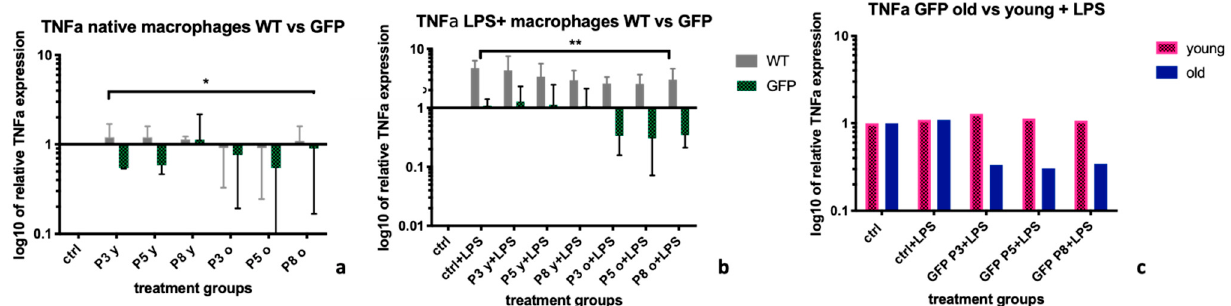
Figure 3. TNF α expression levels in BMDMs after treatment with MSC-wildtype versus MSC-GFP+ supernatants of different age groups and passages. The graph shows the influence of different supernatants from Mesenchymal Stromal Cells on the expression levels of Tumor necrosis factor α (TNF α ) on BMDMs extracted from a WKY-WT rat . Supernatants from MSCs extracted from GFP+ donors led to a significantly better reduction of TNF α expression levels after stimulation with lipopolysaccharide (LPS) than supernatants from WT-MSCs ( p = 0.04, calculated using Mann-Whitney U test, ( a )). Particularly supernatants from older GFP+ rats led to a decrease of TNF α expression levels ( b ). Within the MSC-GFP+ treated group, TNF α expressions were particularly downregulated after treatment with supernatants coming from the older donors, when compared to supernatants from younger donors ( c ). mRNA levels were calculated using RT-PCR and the ∆∆ Ct-method. Untreated BMDM served as control and HPRT-1 was the housekeeping gene. Statistical significance: no statistical significance (ns; no asterisk); p < 0.05 (*); p < 0.005 (**). BMDM= bone marrow derived macrophages, TNF α = Tumor necrosis factor α , WT = supernatants coming from wild-type cells, GFP = supernatants from GFP + cells. Old = supernatants from cells from donor rats > 6 months of age, young= supernatants from cells from donor rats < 6months of age.